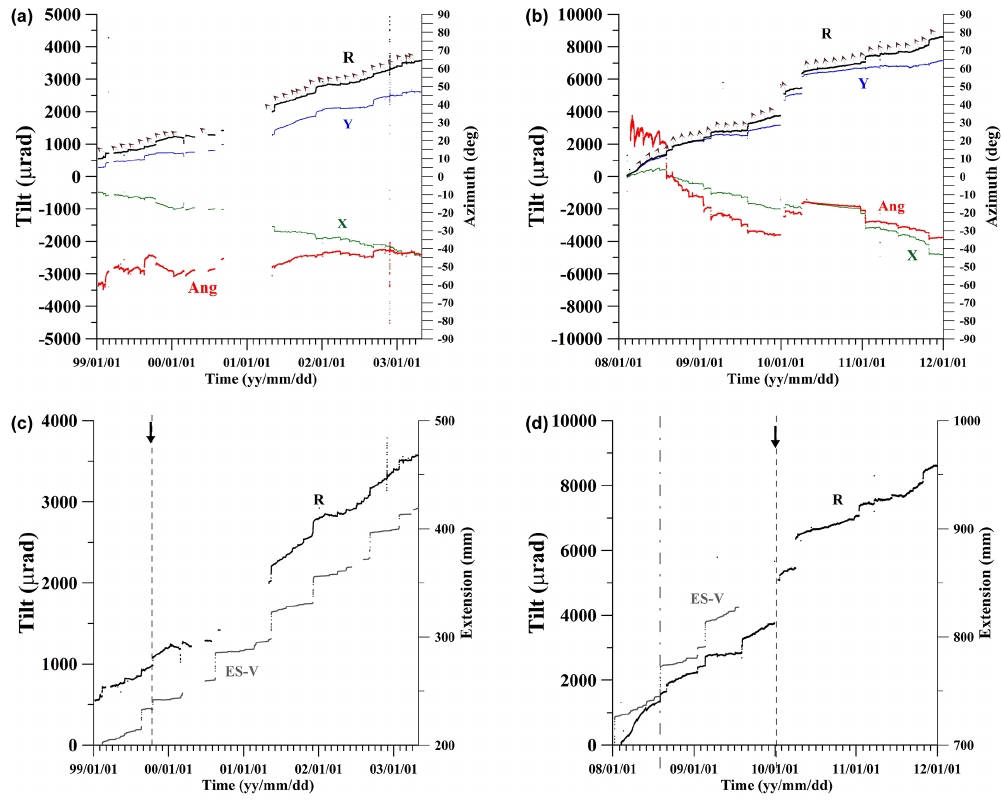
Figure 2. Tilt observations. X and Y are the East-West and North–South components of tilt, respectively, and R is the resultant tilt magnitude in the azimuth direction, Ang, for 1999–2003 (a) and 2003–2012 (b) . X , Y and R are referred to the left axes, while azimuth Ang is referred to the right axes. Azimuth is also shown by the direction in which brown arrowheads point, with North straight up. Extension ES-V and magnitude R for 1999–2003 (c) and 2008–2012 (d) . The vertical arrow indicates the M = 7.2 hector Mine earthquake in (c) , and M = 5.8 2009 earthquake in (d) . The dotted-line indicates slip event in August